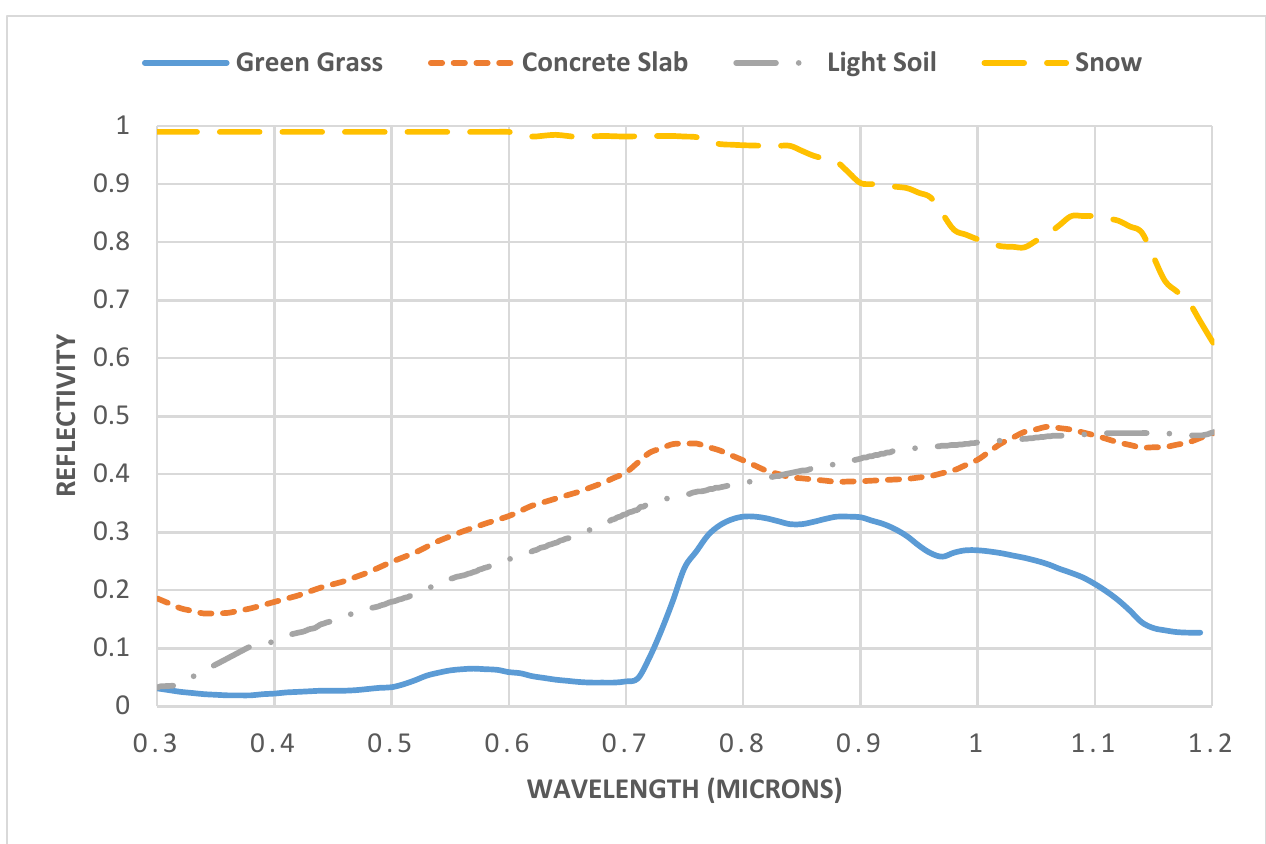
Figure 4. Normalized spectral responses of the front and rear of a mono-crystalline silicon bifacial module [36].